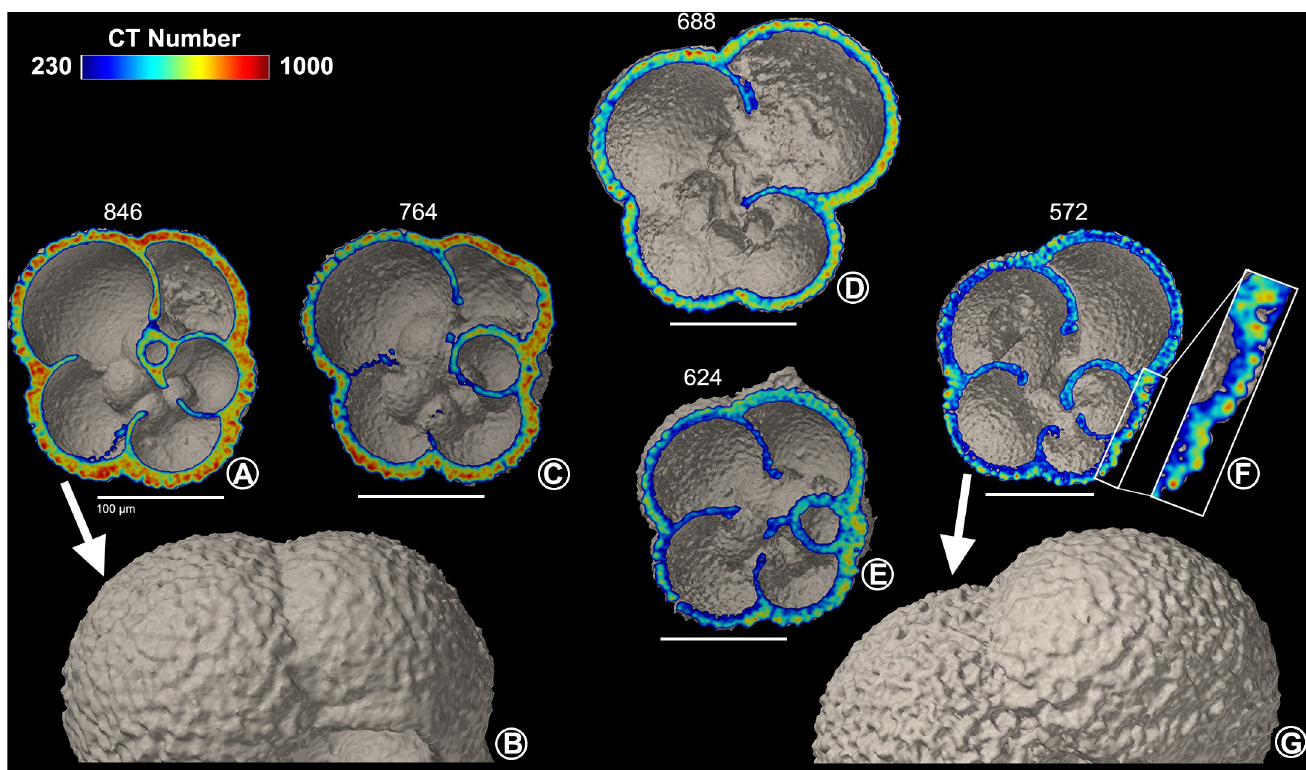
Fig 7. Neogloboquadrina pachyderma from surface sediments. Cross-sections of Neogloboquadrina pachyderma specimens (A,C,D,E,F) from surface sediment sample (0–1 cm), including surface texture of a B) high-density (n = 3) and a G) low-density specimen (n = 9). F) Close-up of shell wall cross-section. Scale bars measure 100 μ